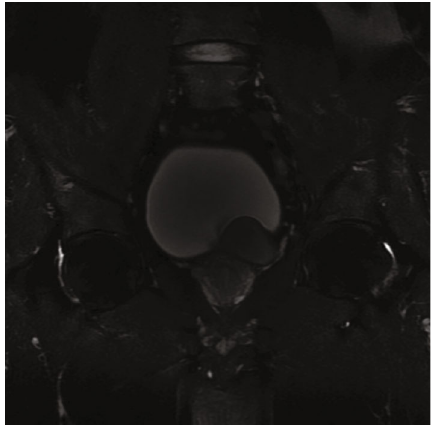
Figure 3: MRI coronal image in the T2-weighted sequence showing a seminal vesicle lesion which is separated from the prostate by its